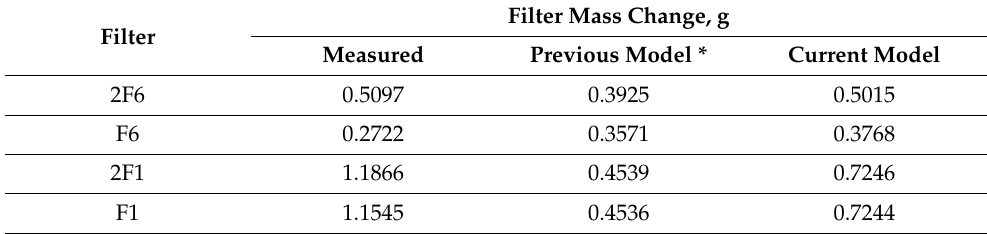
Table 4. Sample mass changes during oil aerosol filtration.